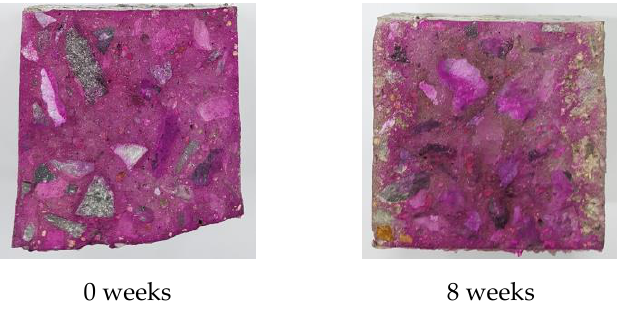
Figure 5. Carbonation test results for OPC.